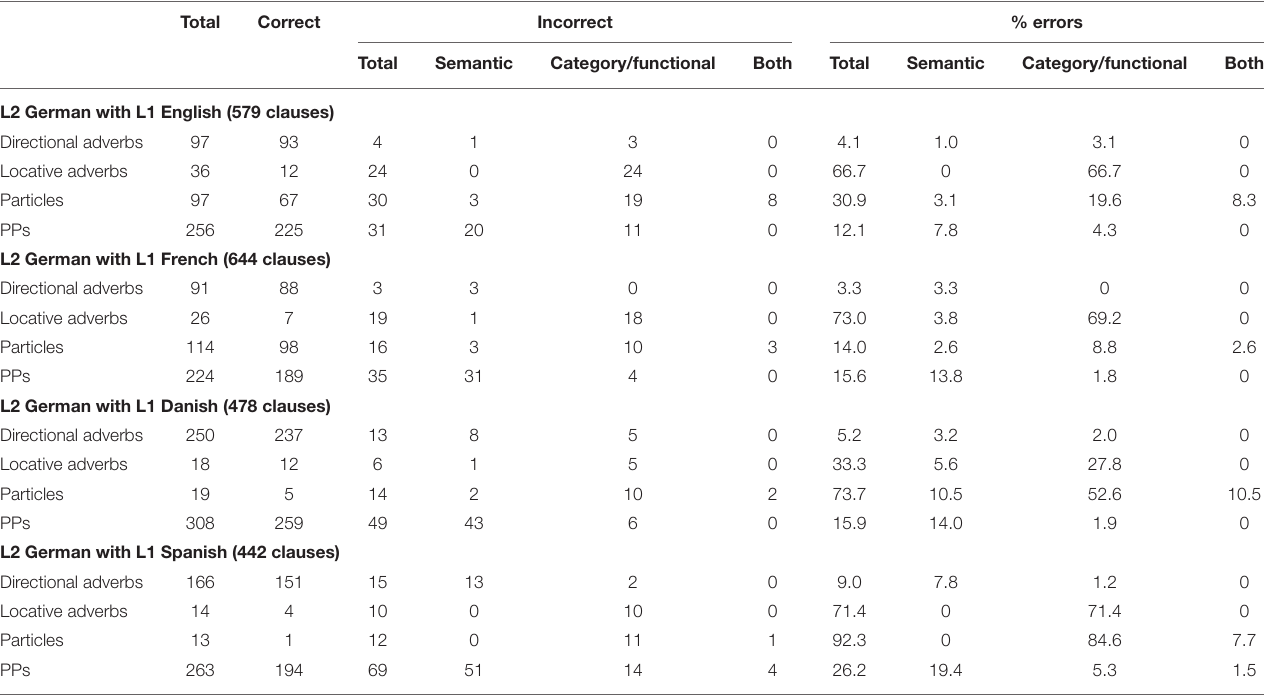
TABLE 2 | Proportions of major categories of path encoding devices in L2 productions (data sets 1 and 2, cartoon and picture book retellings, oral data); columns “both” represent learner productions where choices are both semantically and functionally incorrect (e.g., anklettern lit. ‘on-climb’ for rauf klettern ‘climb up’). Total Correct Incorrect % errors Total Semantic Category/functional Both Total Semantic Category/functional